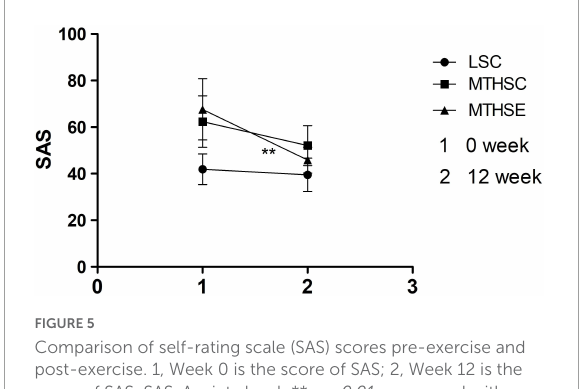
FIGURE5 Comparison of self-rating scale (SAS) scores pre-exercise and post-exercise. 1, Week 0 is the score of SAS; 2, Week 12 is the score of SAS; SAS, Anxiety level; ** p < 0.01 , compared with Pre-intervention.